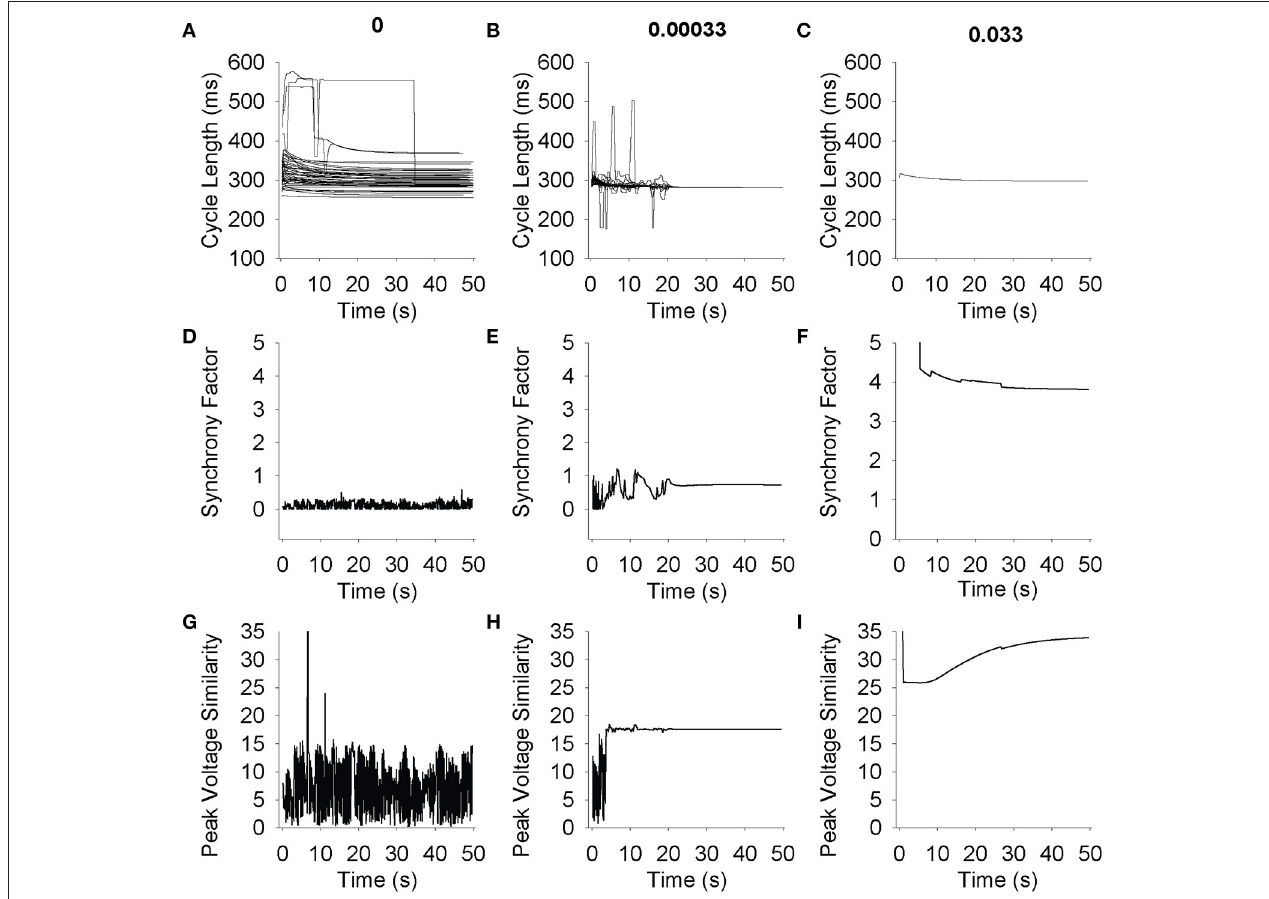
FIGURE 7 | Simulations were run on a 7 × 7 grid for 50s. Each cell was randomly perturbed using a lognormal distribution with a mean of 1 and a standard deviation of 0.2. (A–C) Cycle length for 49 cells is shown over time. At low conductivities (A) cells do not synchronize, and as conductivity increases the cells begin to interact and find a common cycle length (B) and eventually fire at a common cycle length immediately (C) . (D–F) Synchrony factor vs. Time. The synchrony factor measurement is the longest amount of time it takes the peak of the action potential to propagate from any cell to its neighbor. Low values indicate random and low synchrony factor waves (D) . The larger peaks and valleys that appear in higher conductivities (E) correlate with spiral wave formation and multiple wave fronts in the grid. When cells interact and fire in cohesive synchronization (F) , synchrony factor becomes higher and stabilizes. (G–I) Peak voltage similarity vs. Time. The peak voltage similarity measurement is the inverse of the standard deviation of the voltage values across the grid. Low conductivities indicate random noisy peak voltage similarity waves (G) . As conductivity increases, peak voltage similarity increases and stabilizes initial noisy values (H) . At higher conductivities, peak voltage similarity display no errant behavior (I)